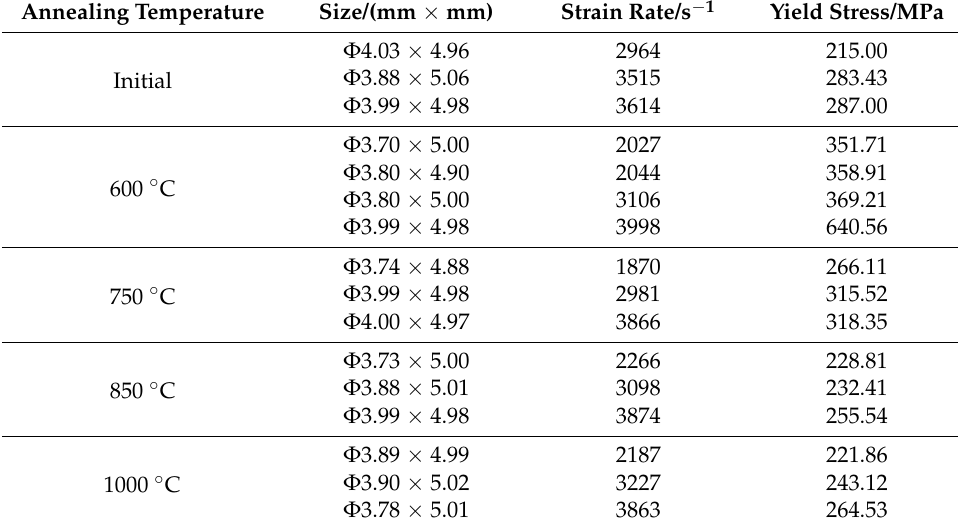
Table 2. SHPB experimental data.